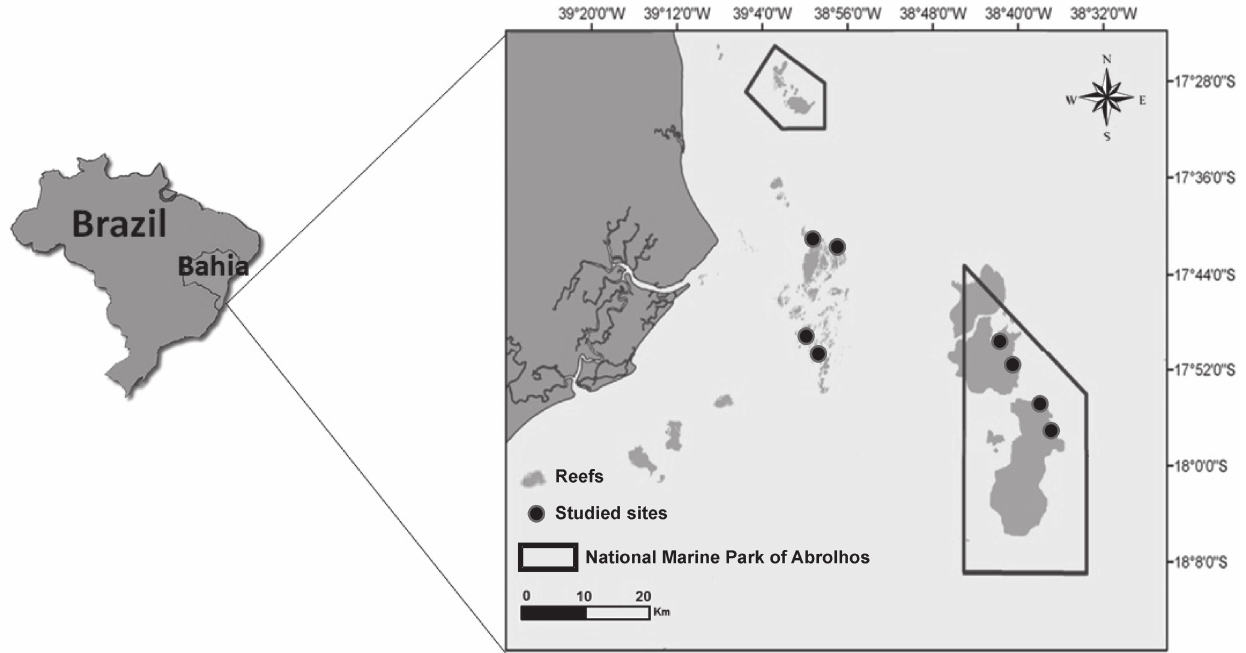
Fig. 1. Map of study area showing sampled sites (MUAs: Multiple-use areas; NTAs: No-take areas) in the Abrolhos